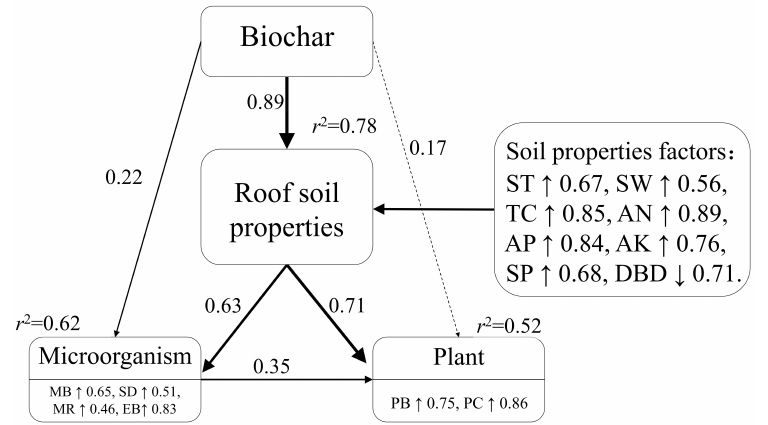
Figure 5. SEM analysis of the biochar effects on green roof microorganisms and plants. Square boxes indicate the variables included in the model: SP = soil porosity, SAK = soil available potassium, MB = microbial biomass, SD = diversity index, MR = richness index, EB = eukaryote biomass, PB = plant biomass and PC = plant carbon content. For ST, SW, TC, AN, AP and DBD, see Table 2. The symbols “ ↑ ” and “ ↓ ” indicate a significant increase or decrease, respectively, in response to the biochar addition. The number indicates the response to the addition of the additives. Solid and dashed arrows indicate significant ( p < 0.05) and nonsignificant effects ( p > 0.05), respectively. r 2 values associated with the response variables indicate the proportion of the variations explained by the relationships with other variables. The values associated with the solid arrows represent standardized path